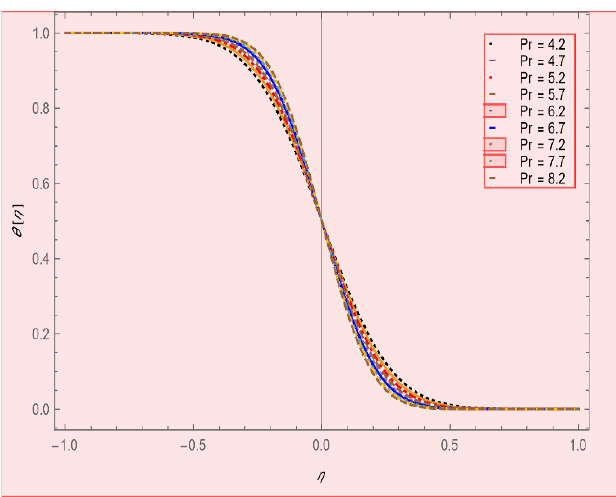
Figure 8. Radial velocity profile for 𝜑 1 = 𝜑 2 = 0.01, 𝛼 = 1,𝑅𝑒 = −1.